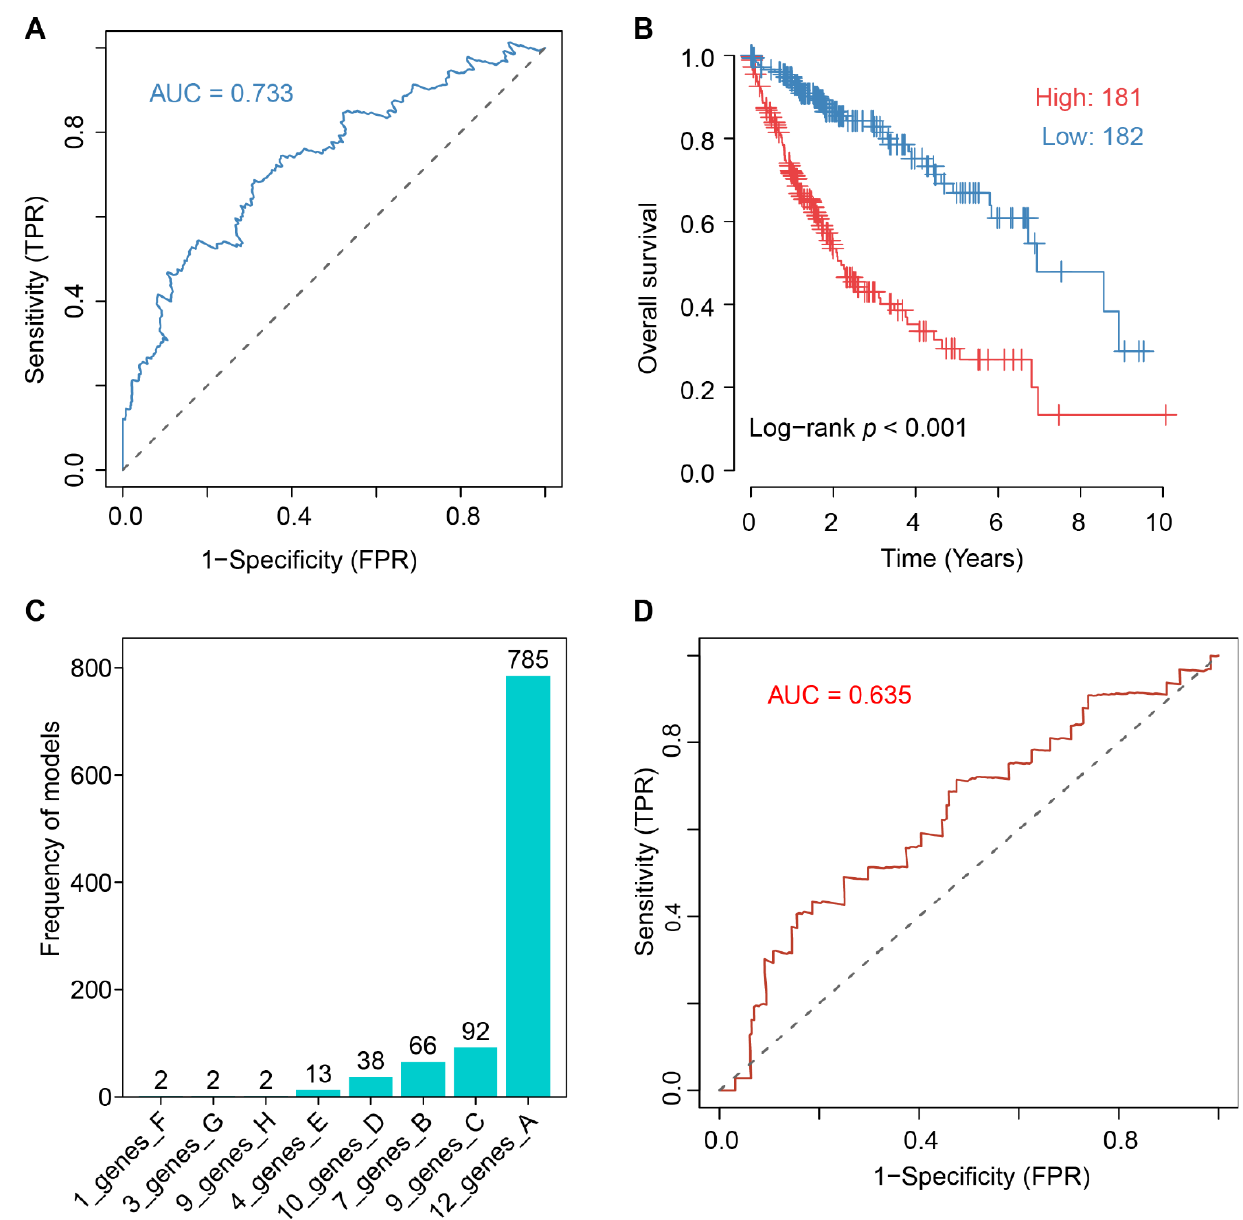
Figure 6. Elastic net-based survival approach for construction of risk score model. ( A ) Receiver operating characteristic (ROC) of the 12-PRG risk score model. ( B ) Performance of risk score model to discriminate included 361 samples. ( C ) Recurrence of models generated by random seeding in 1000-iteration simulation of elastic net modeling. ( D ) Validation of 12-PRG model on GSE14520 cohort.